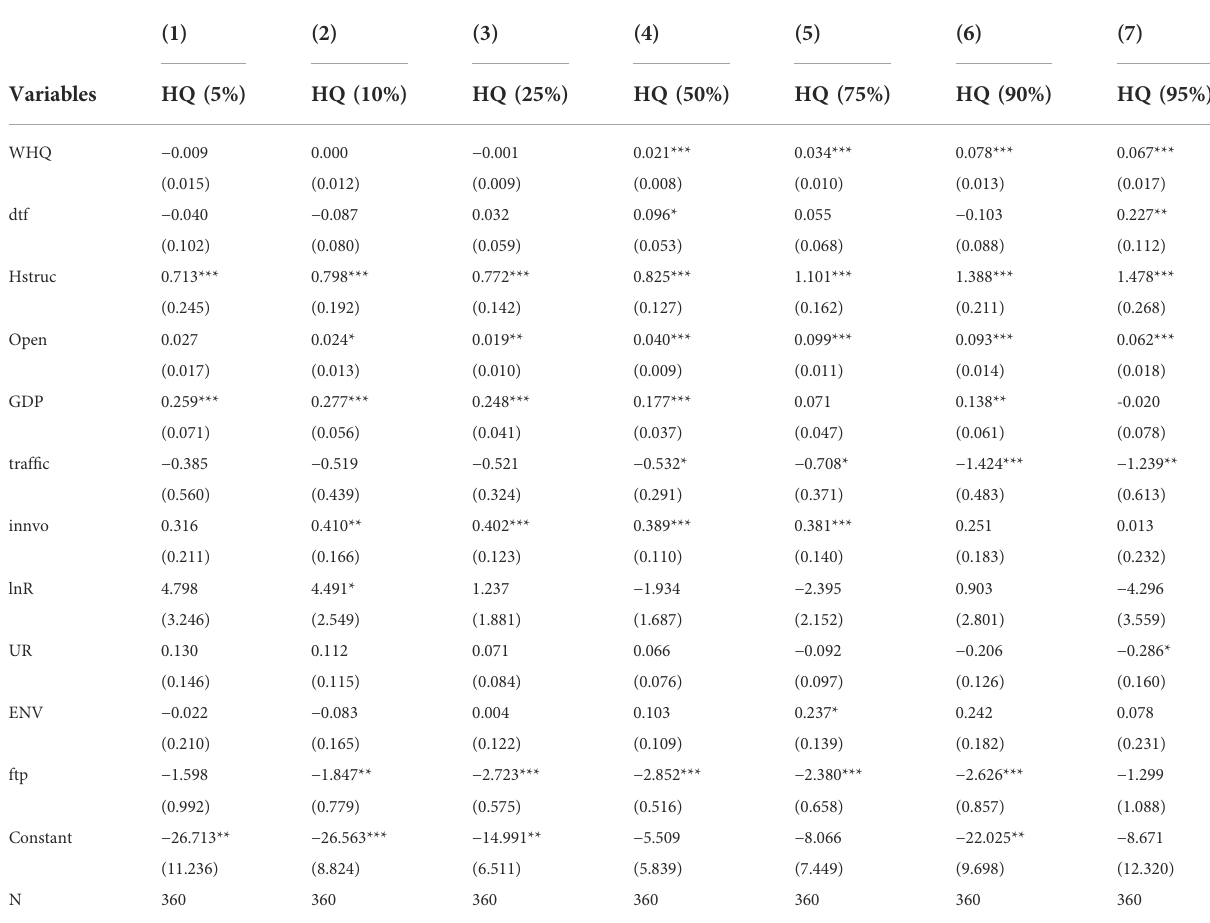
TABLE 18 Spatial quantile estimation